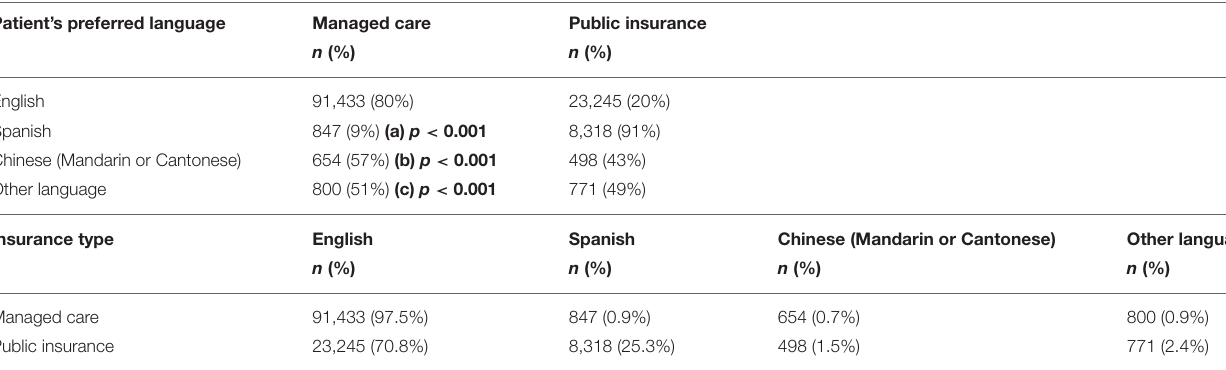
TABLE 3 | Preferred language and insurance